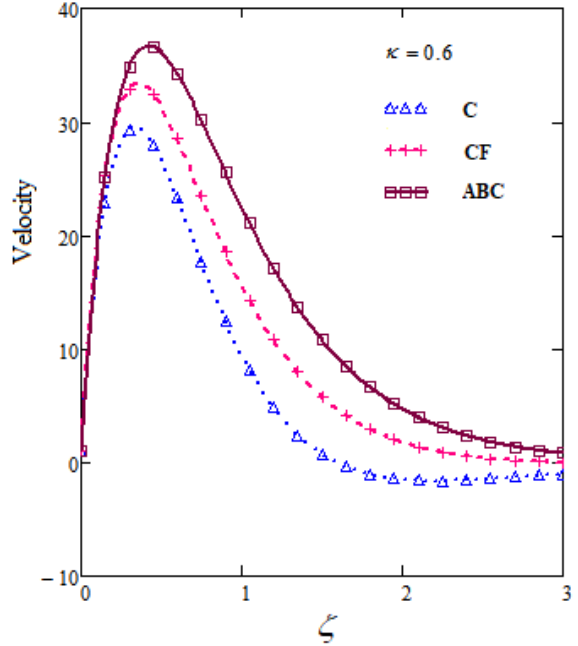
Figure 10. Velocity curves corresponding to fractional models with κ = 0.6 and P r = 7, S c = 0.66, κ = 0.5, G m = 5, H = 3, S r = 3, G r = 10, K r = 2, M = 0.5, γ 1 = 0.1, h = 0.5, c = 1.05 and b =